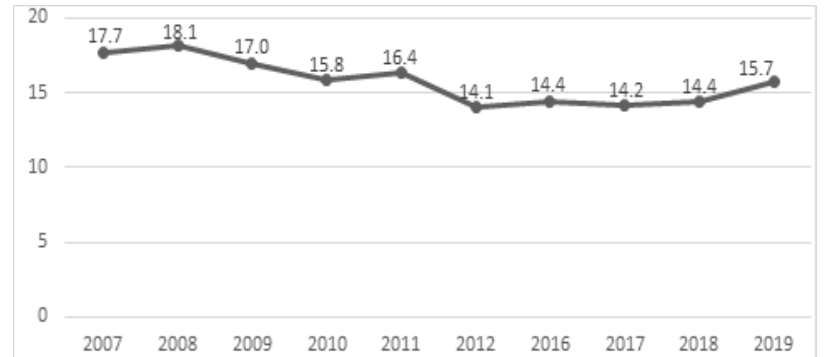
Figure 1: Export development of Indonesian MSMEs, 2007-2019 (% of Total Exports) Source: Menegkop & UKM